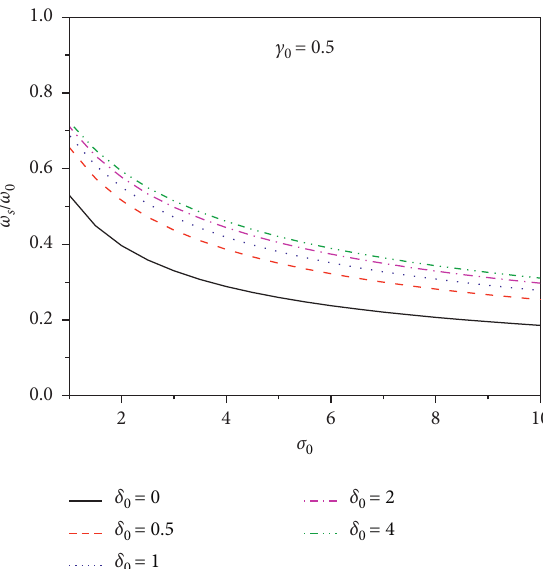
Figure 9: The variation in the ratio ω different values of δ